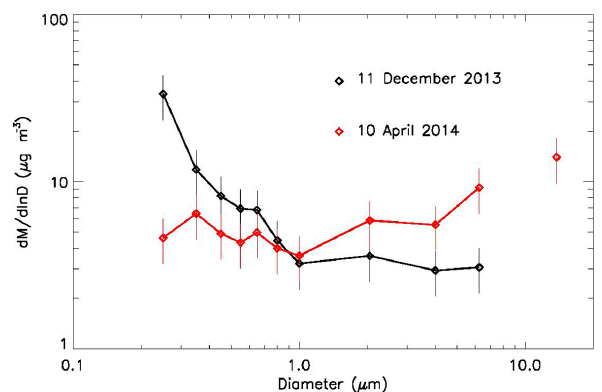
Figure 10. Comparison of the mass concentration distribution for the strong pollution event on 11 December 2013 and for the low pol- lution conditions on 10 April 2014; the measurements are at